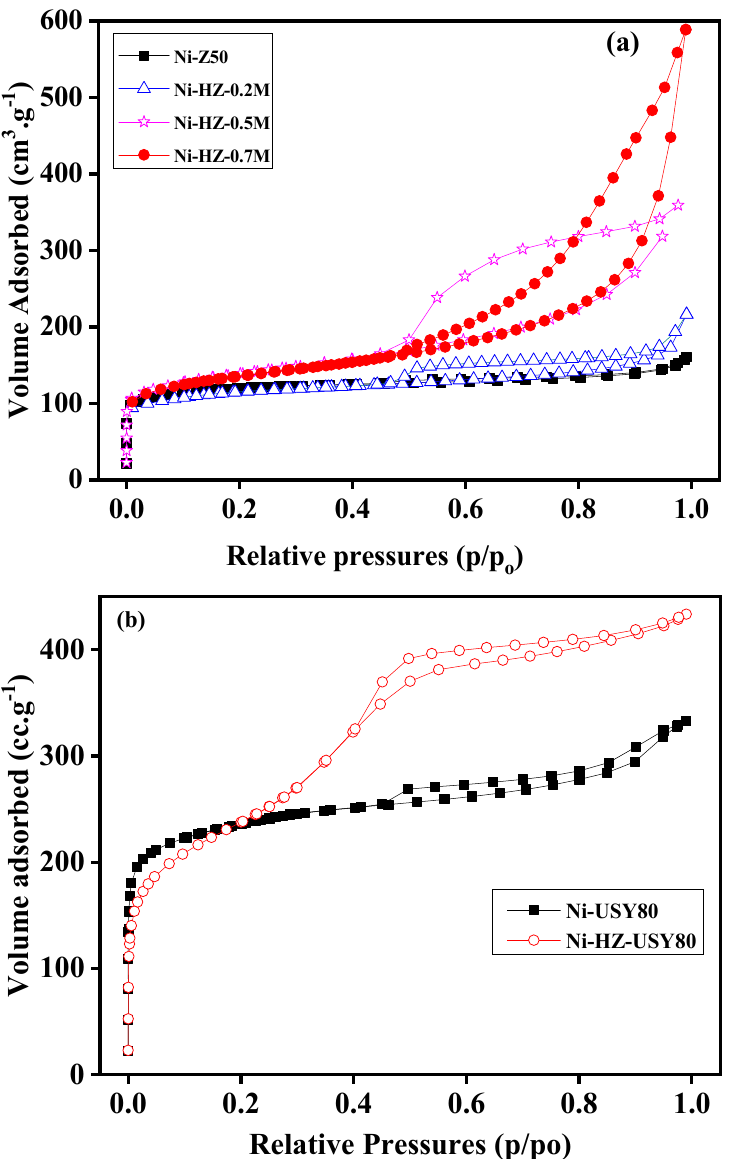
Ni-Z50, Ni-HZ-0.2 M, Ni-HZ-0.5 M, and Ni-HZ-0.7 M; whereas ( b ) shows nitrogen sorption isotherms of nickel supported hierarchical USY type zeolites samples (Ni-USY80 and Ni-HZ-USY80). BJH pore size distribution analyses of parent zeolite and hierarchical zeolite samples